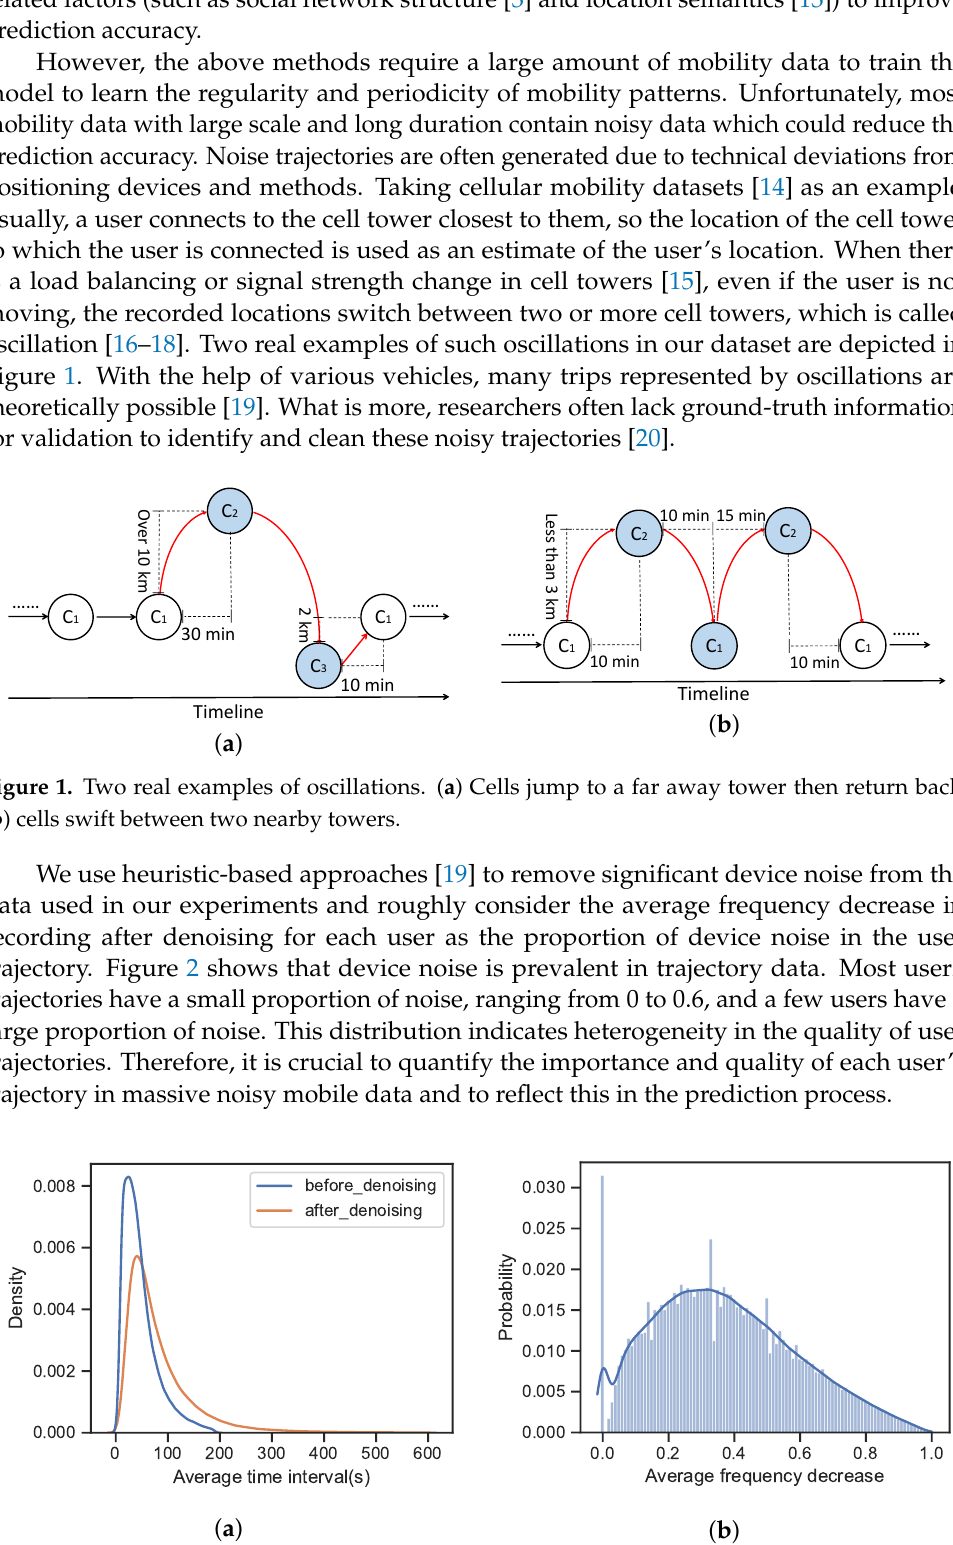
Figure 2. ( a ) Average time interval of user recordings before and after denoising; ( b ) average frequency decrease in user recording by denoising